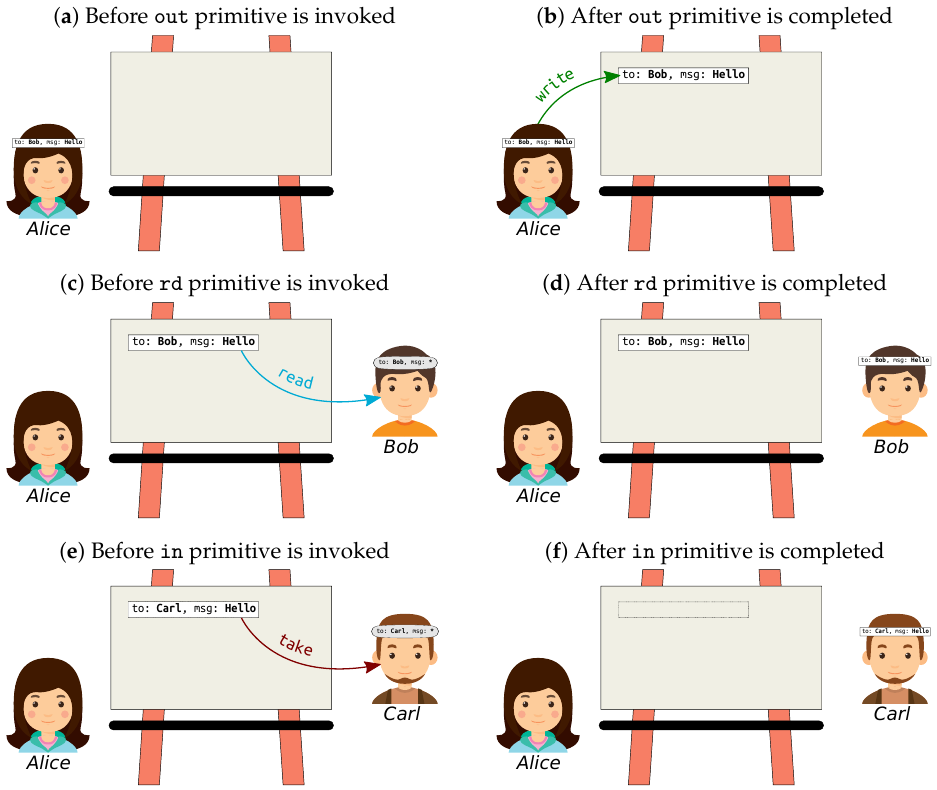
Figure 1. Graphical representation of L INDA primitives behaviour: tuple spaces are “blackboards” available to agents, which put ( out , subfigure a , b ), read ( rd , subfigure c , d ), and withdraw ( in , subfigure e , f ) data chunks called